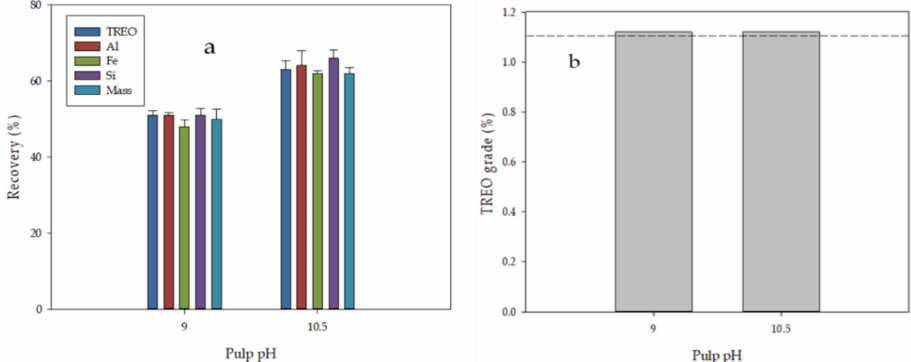
Figure 4. ( a ) TREO, mass, and gangue species recoveries and ( b ) TREO grade as a function of pulp pH 9 and 10.5 (dash line represents feed grade = 1.14%